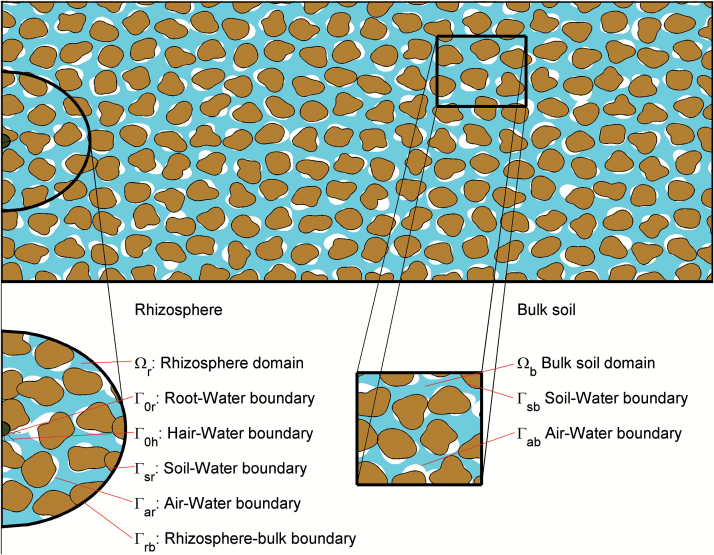
Schematic of the different regions used in the mathematical formulation of the problem. The bulk and rhizosphere regions are highlighted with the modelling domains Ωr,
Γ0r,
Γ0h,
Γsr,
Γar, and Γrblabelled for the rhizosphere and Ωb,
Γsband Γablabelled for the bulk soil. (This figure is available in colour at JXB online.)